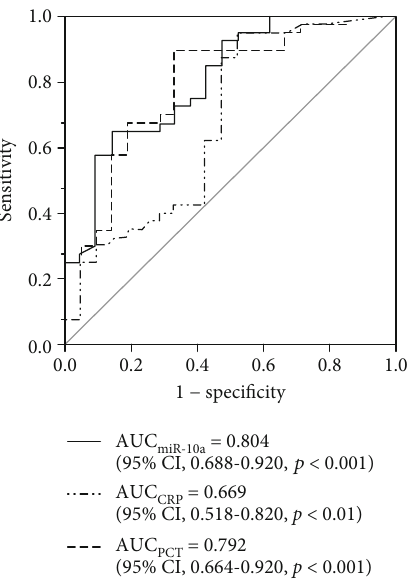
Figure 3: ROC curves for the prediction of sepsis. ROC curves present sensitivity and speci fi city of PBMC miR-10a, CRP, and PCT for predicting